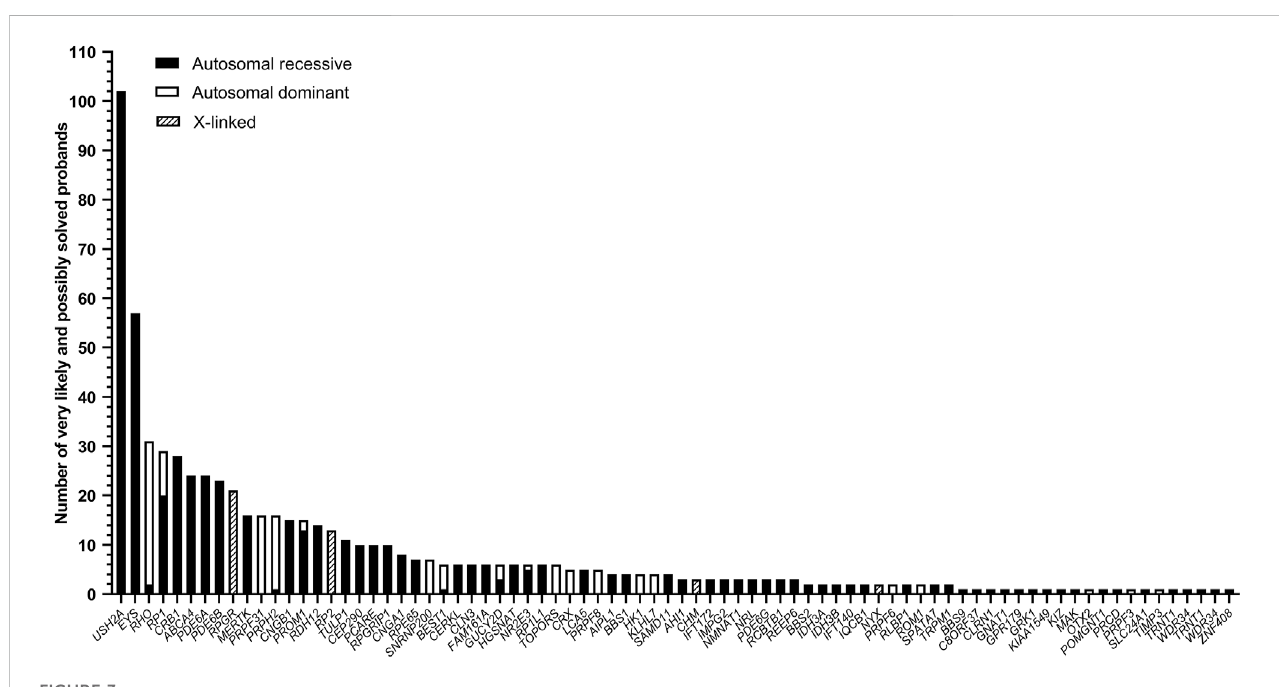
FIGURE 3 Number of solved cases per individual gene. For all genes, the inheritance mode is depicted in either black (autosomal recessive), white (autosomal dominant), or dashed (X-linked inheritance).